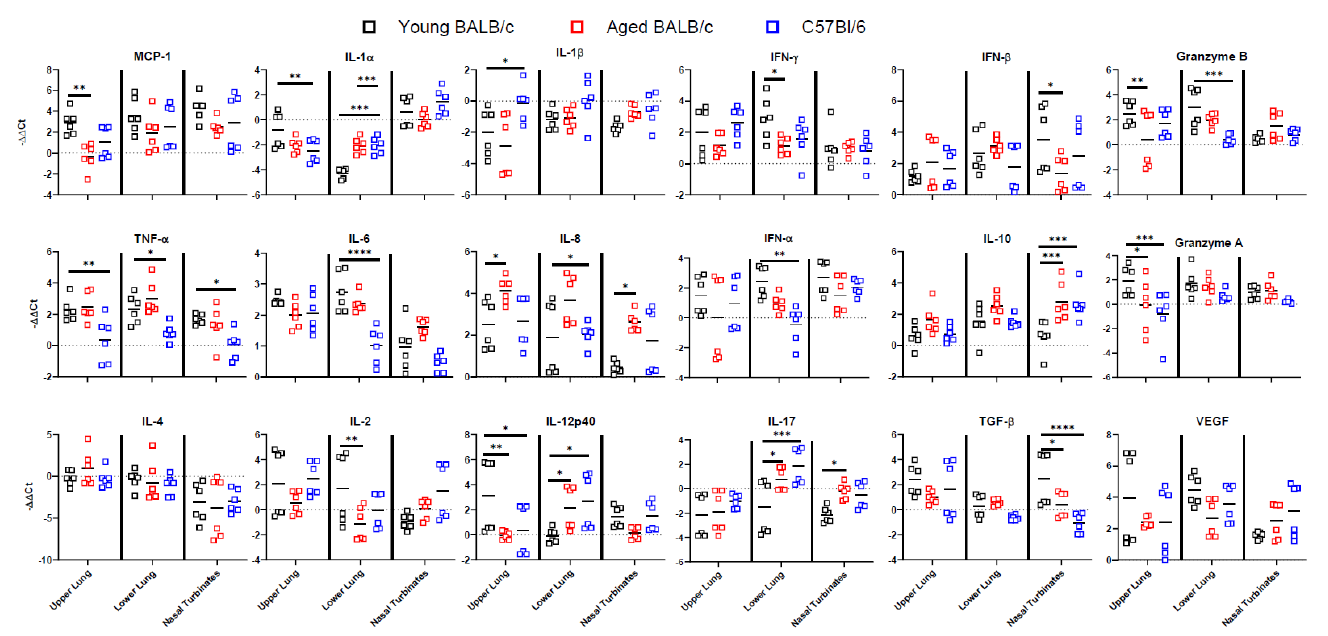
Figure 4. Cytokine gene expression in SARS-CoV-2 infected mice. Gene expression of selected cytokines normalized to GAPDH (ΔΔCt values) and compared to luciferase transduced mice in the upper lung, lower lung, and nasal turbinates on day 4 post-SARS-CoV-2 infection. All mice shown here were mice transduced with AAV6.2FF-hACE2 prior to SARS-CoV-2 infection. Comparisons between young and aged BALB/c mice and BALB/c and C57Bl/6 mice were done using two-way analysis of variance. * = p < 0.05, ** = p < 0.01, *** = p < 0.001, **** = p < 0.0001. n = 6/group TNF-alpha, Tumour Necrosis Factor alpha; TGF-beta, Transforming growth factor beta; MCP1, Monocyte Chemoattractant Protein-1; VEGF, vascular endothelial growth factor; GAPDH, Glyceraldehyde 3-phosphate dehydrogenase.